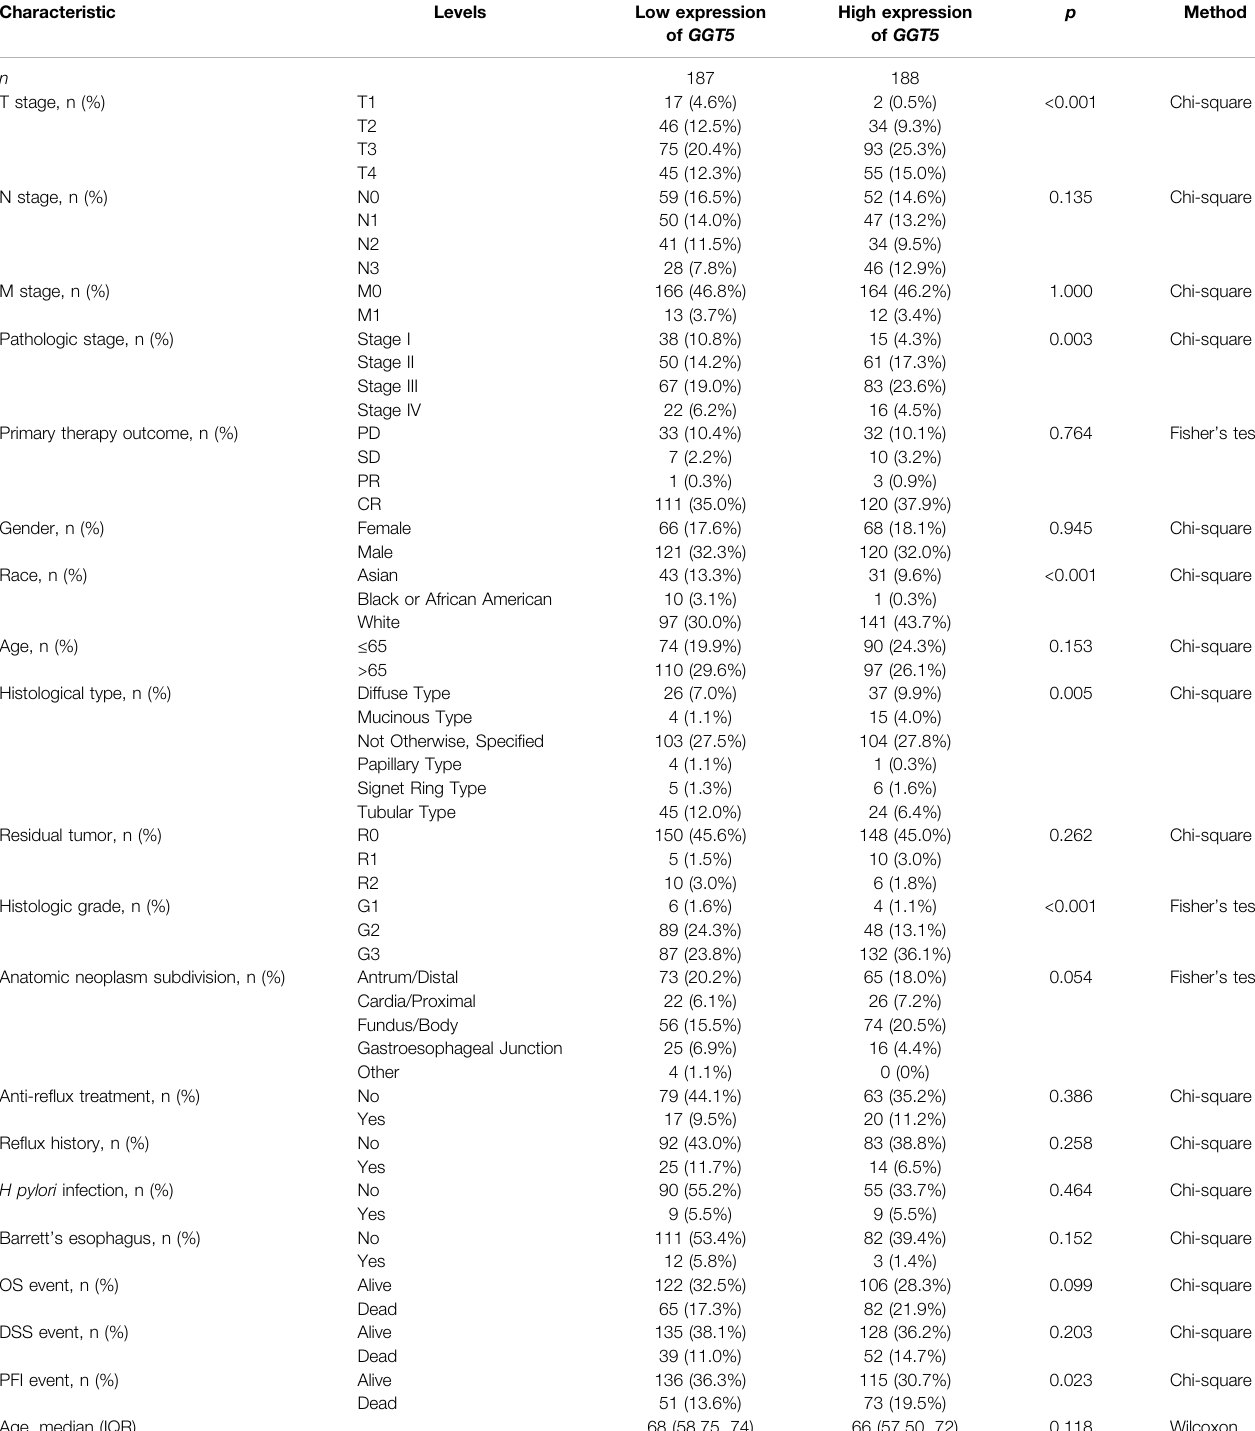
TABLE 1 | Clinical characteristics of gastric cancer patients in the GGT5 -high and the GGT5 -low expression groups.